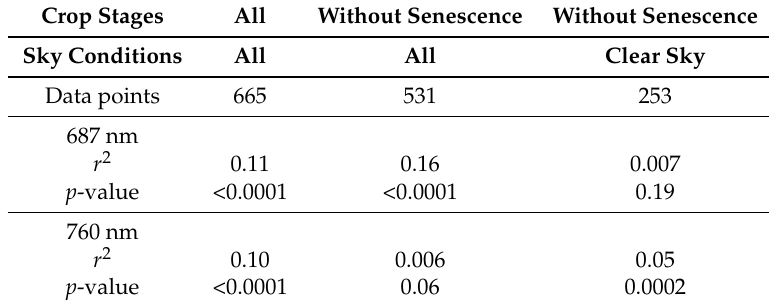
Table 6. Statistics of the linear regression between half-hourly light use efficiency (LUE) and spectral fluorescence yield (SFY) for different crop stages and sky conditions. The analysis includes data between DOY 97 and 167 when fAPAR data is